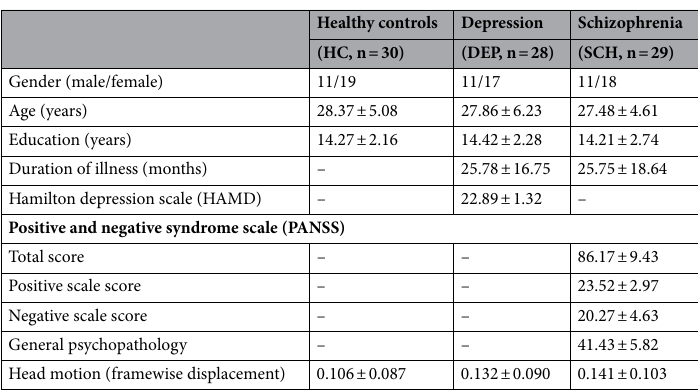
Table 1. Demographic and clinical characteristic of all participants. Groups were matched for gender, age, and education (chi-square test or tone-way ANOVA p >